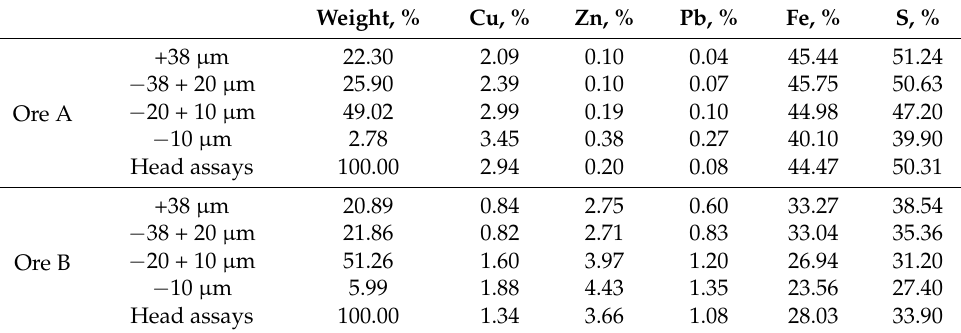
Table 1. Chemical composition of Ore A and Ore B on a size by assay